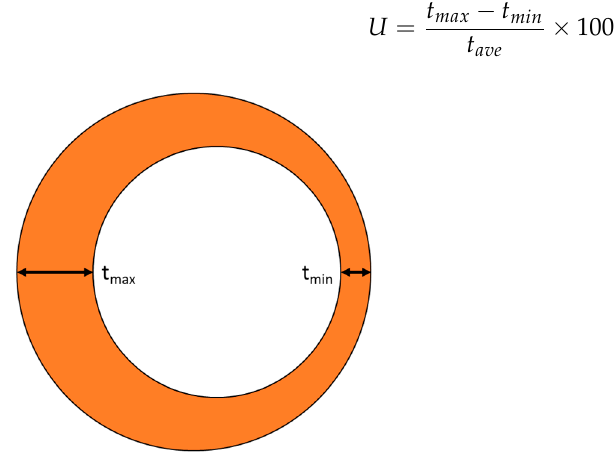
Figure 1. Schematic tube cross section emphasizing eccentricity.